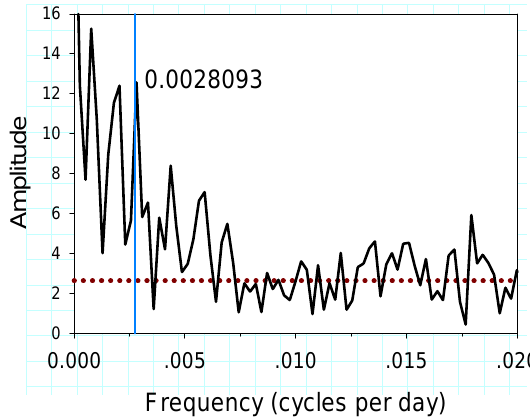
Figure 5: FFT spectra for an 11-year interval at Roded site. The peak of 0.0028093 cycles Fig. 5. FFT spectra for an 11-year interval at Roded site. The peak per day is a frequency corresponding to the annual periodicity (1/365=0.0027397260, of 0.0028093 cycles per day is a frequency corresponding to the indicated as a vertical line). annual periodicity (1/365=0.0027397260, indicated as a vertical